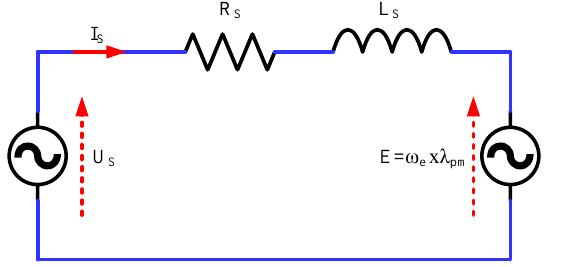
Figure 3. Equivalent circuit of PMSM in steady-state